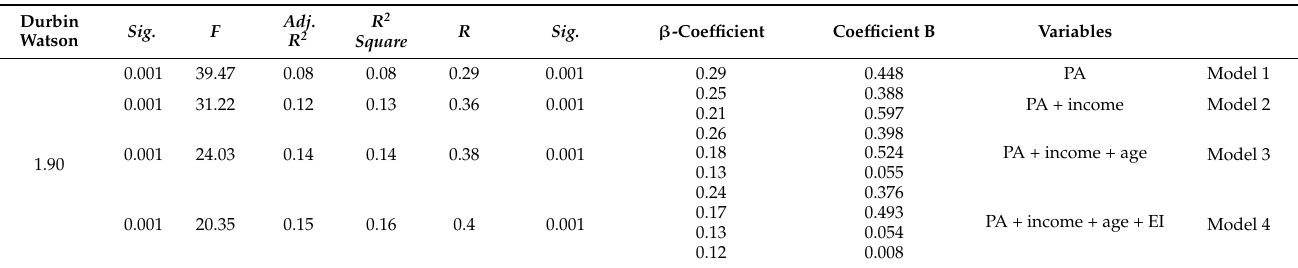
Table 4. Stepwise regression of variables affecting AHEMD.